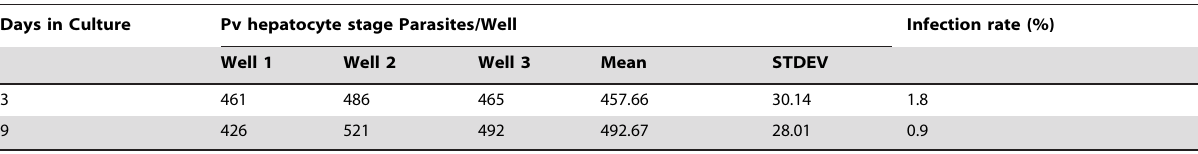
Table 1. In vitro development of hepatocyte stage parasites.